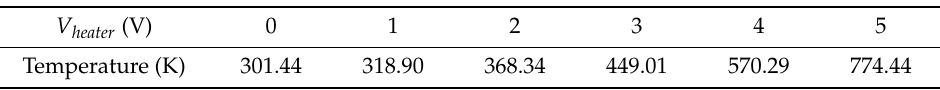
Table 3. The plate temperature as a function of heater voltage evaluated from the measurements of Figure 8.